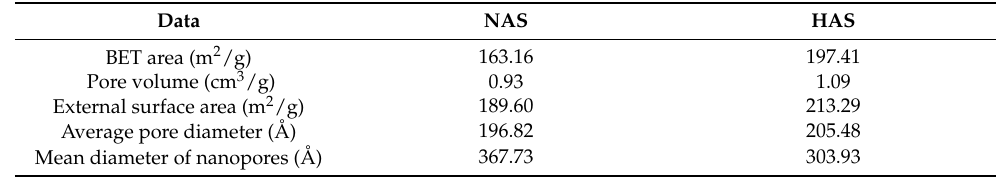
Table 2. BET total specific area values, pore volume, external surface area, and average pore and nanopore diameter of the